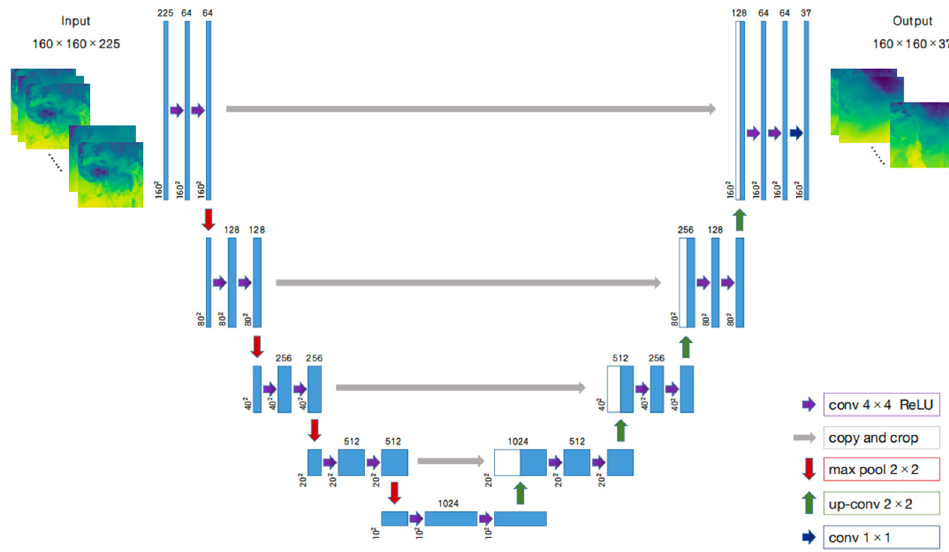
Figure 4. U ‐ Net model